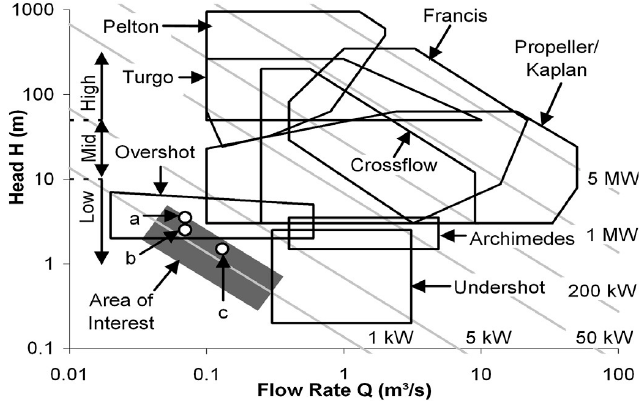
Figure 1. The typical range of flow rates and application heights of each type of turbine in [3].